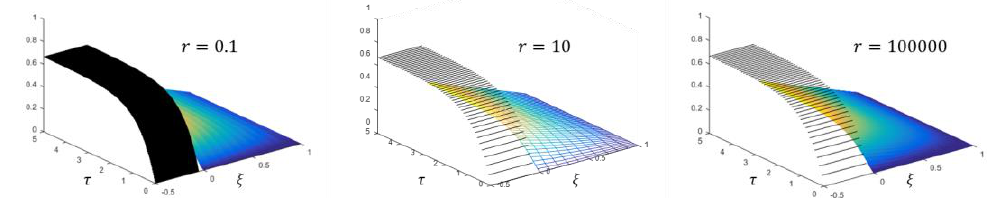
Figure 8. The solutions ψ ( τ ) (black) and θ ( ξ , τ ) (color) for three different values of r . Example 3